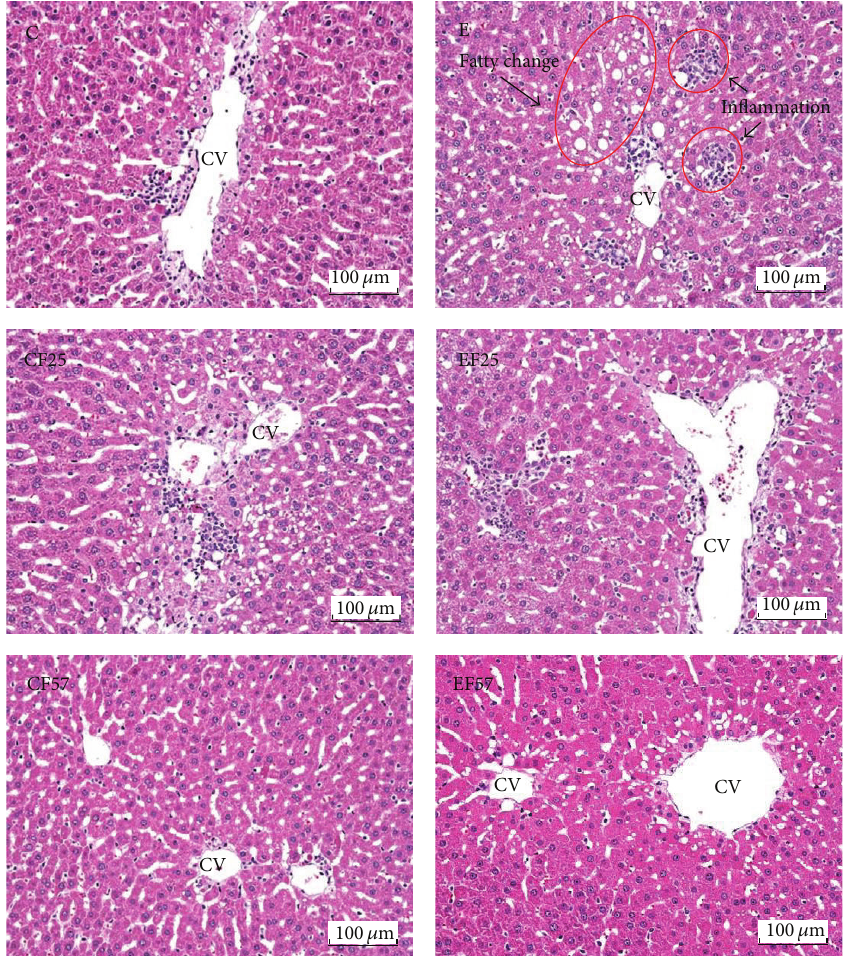
Figure 1: Representative photomicrographs of livers (H&E stain, magnification: × 200). C, control; CF25, control with 25% fish oil substituted for olive oil; CF57, control with 57% fish oil substituted for olive oil; E, ethanol; EF25, ethanol with 25% fish oil substituted for olive oil; EF57, ethanol with 57% fish oil substituted for olive oil. CV, central vein. Fatty change and inflammation (arrows) occurred in E group while there were few histopathological changes in the other